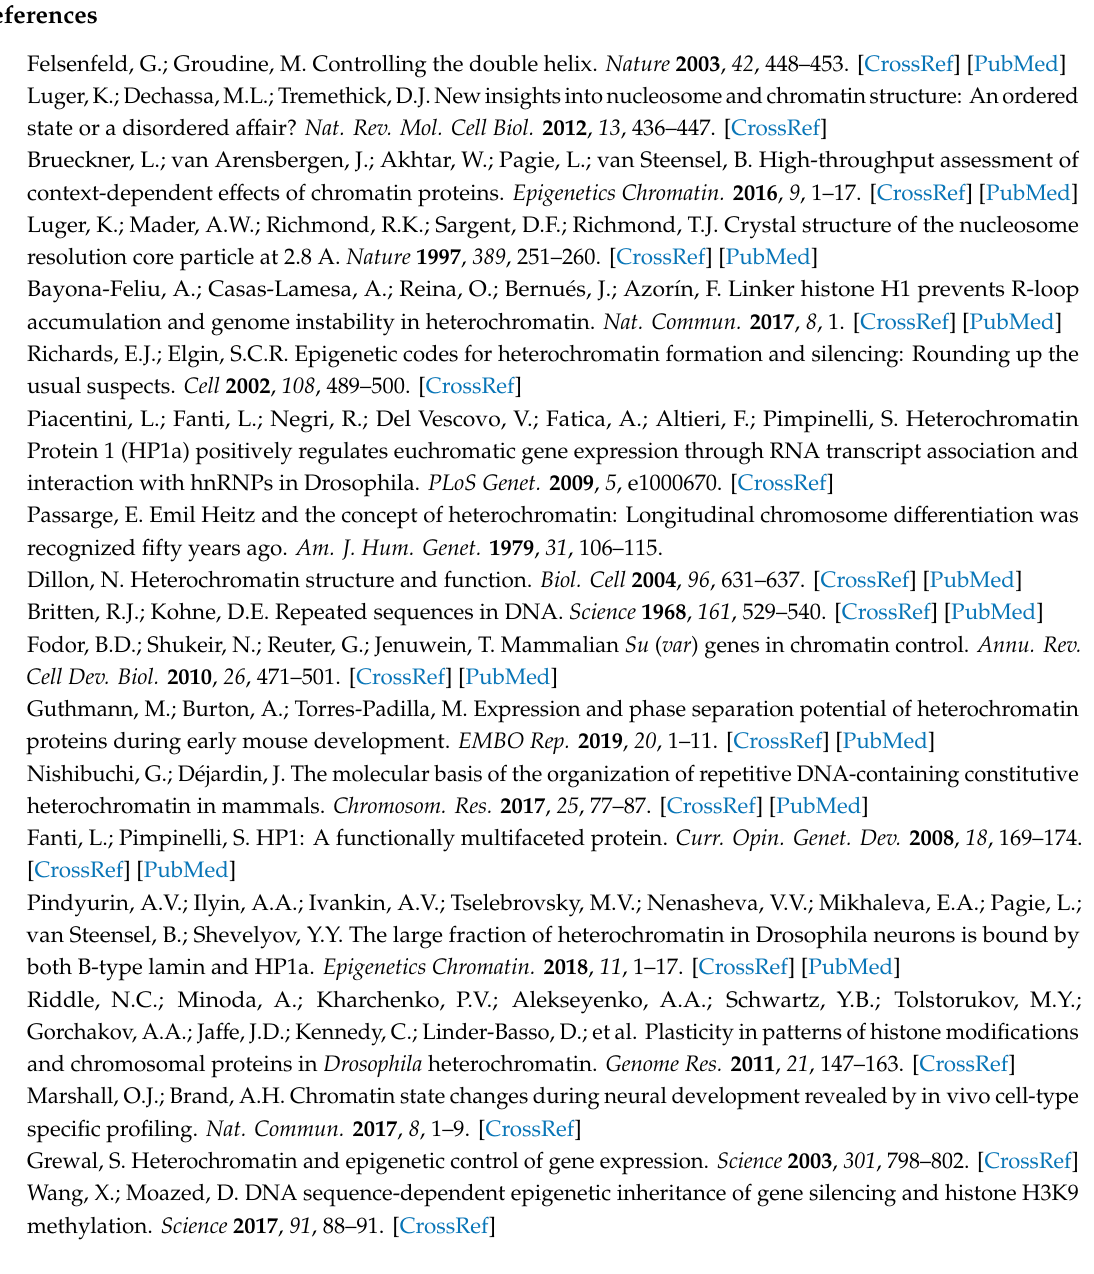
Table S1: Publicly available ChIP-seq data for S2 cells; Figure S1: Permutation test for overlap between HP1a and architectural